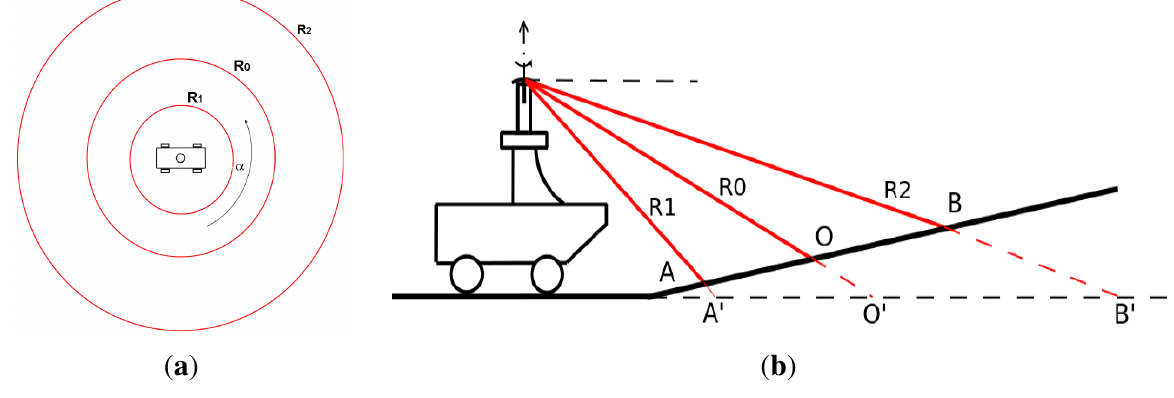
Figure 4. Radar beam model for flat, horizontal ground, up view ( a ); Uphill ground in view of the radar ( b ).